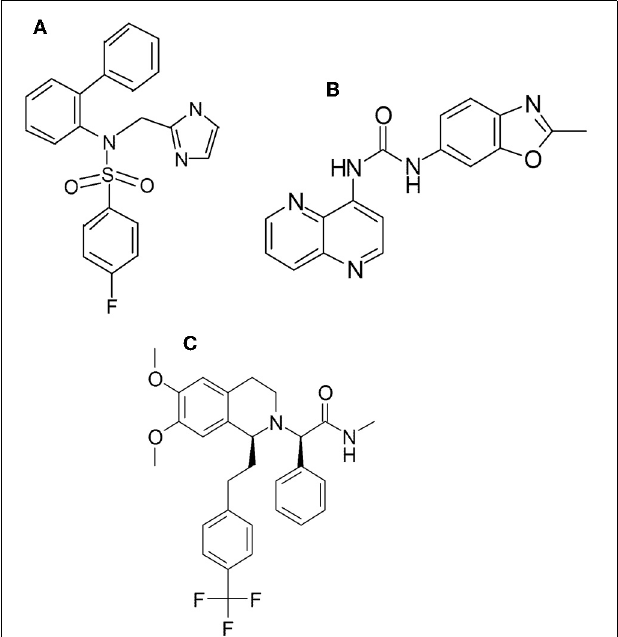
FIGURE 1 | Chemical structure of LSN2424100 (A), SB334867 (B), and almorexant